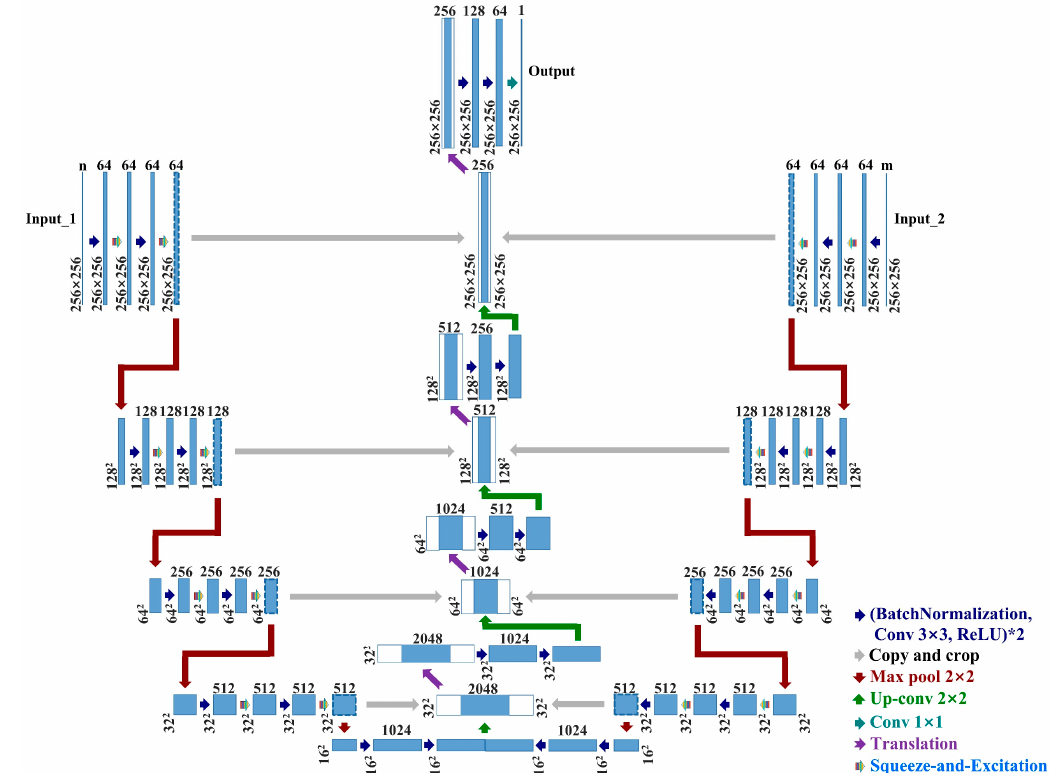
Figure 3. Schematic diagram of the squeeze-and-excitation W-Net